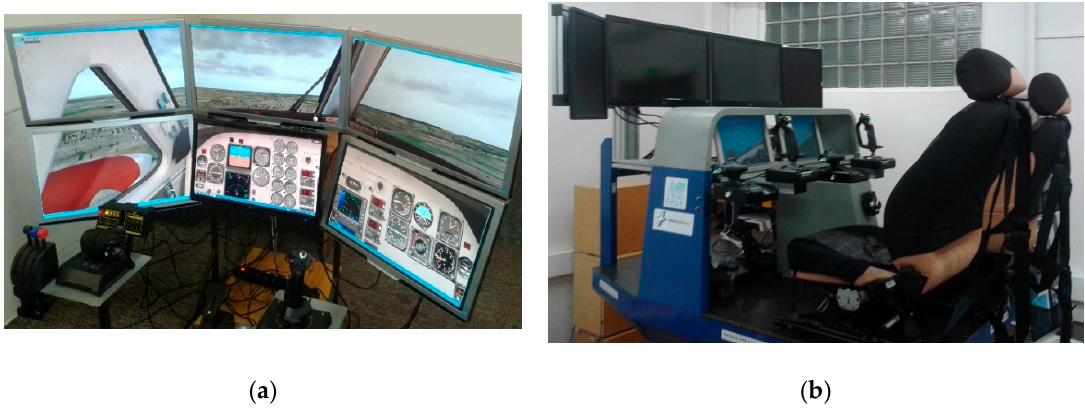
Figure 2. The flight simulators in use—( a ) the fixed-base flight simulator and ( b ) the moving-base flight simulator.